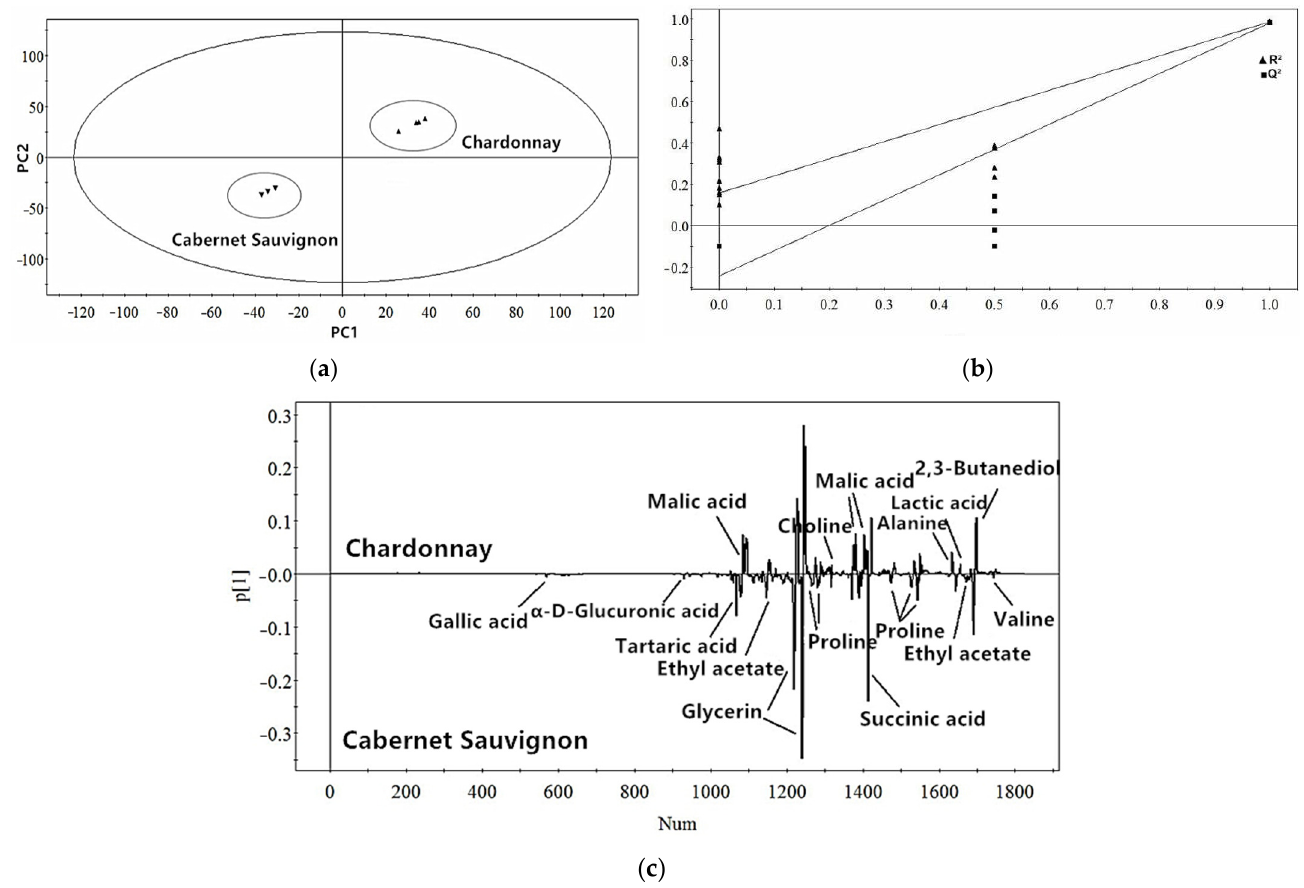
Figure 9. ( a ) PLS-DA model derived from the 1 H-NMR spectra of Cabernet Sauvignon dry red wine and Chardonnay dry white wine. PLS-DA scores plot; ( b ) PLS-DA cross-validation plot; ( c ) PLS-DA loading plot.